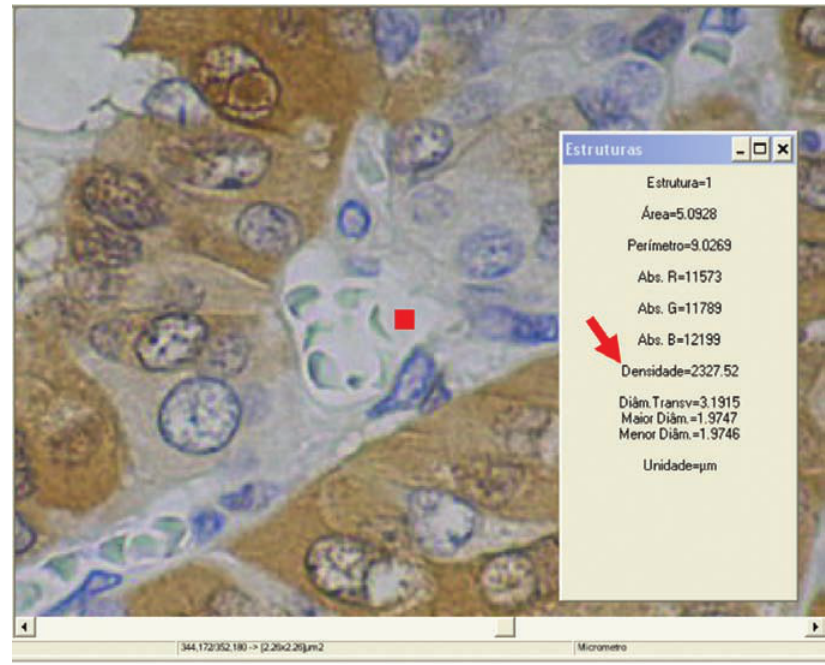
Figure 3 - ImageLab ® software defining the area where there is no tissue reaction (red square) and the calculation of its optic density (arrow).